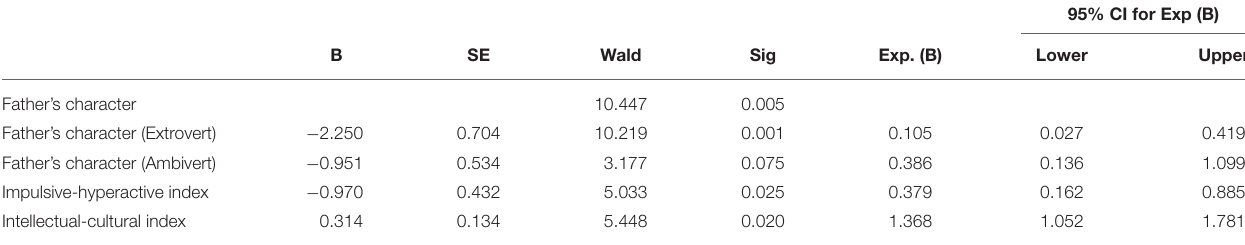
TABLE 2 | Results of the stepwise logistic regression analysis: independent predictors for adult clinical outcome in ADHD boy.